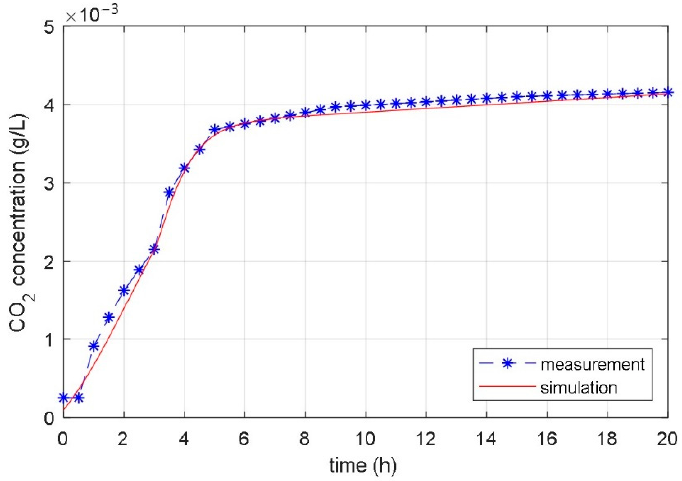
Figure 14. Measured and simulated time courses of the CO 2 concentration during the fermentation process with changeable bioreactor temperature (step change of temperature from 22 °C to 27 °C occurred at time t = 3 h).